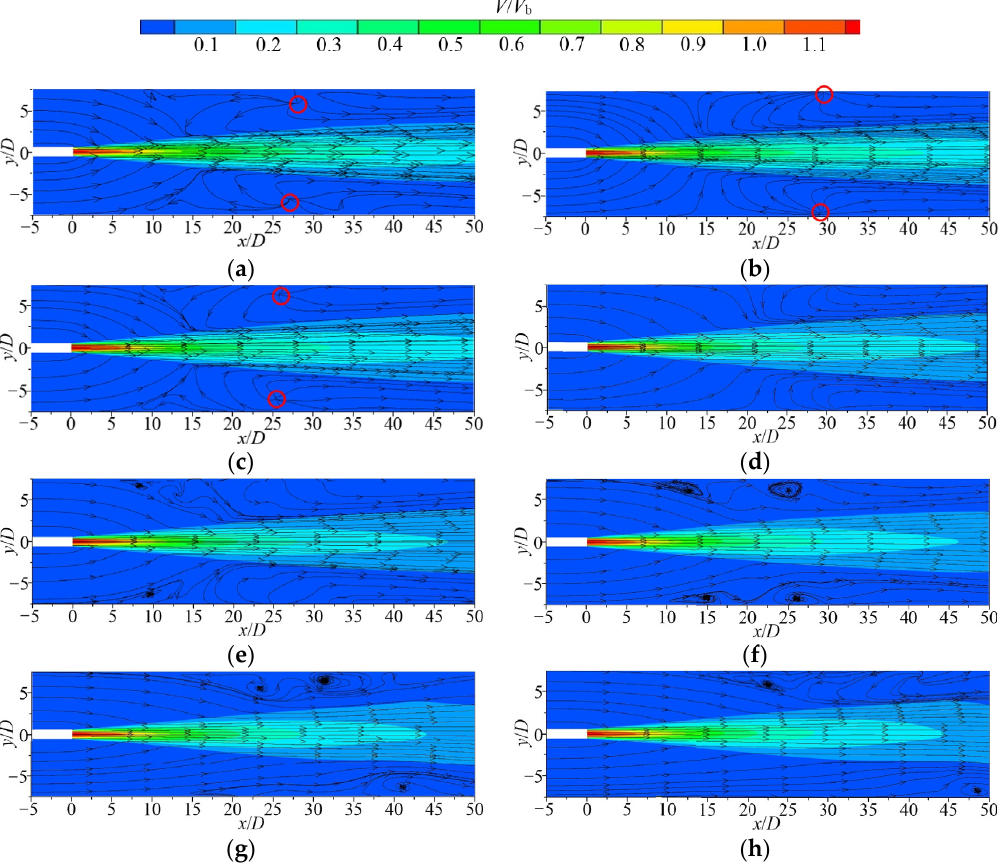
Figure 7. Contours with streamline diagrams of V / V b distribution in the jet cross-section ( oxy plane) under different H / D conditions: ( a ) H / D = 0.5; ( b ) H / D = 0.75; ( c ) H / D = 1; ( d ) H / D = 1.5; ( e ) H / D = 2; ( f ) H / D = 3; ( g ) H / D = 4; and ( h ) H / D = 6.